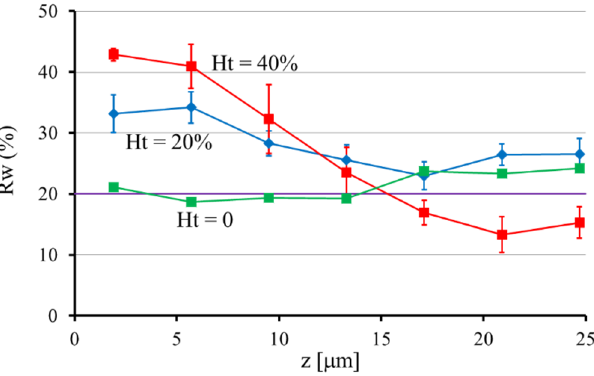
Figure 4. Number fraction of particles lying within 10 µ m from the channel wall, Rw , at various heights from the bottom face of the square channel for Ht = 0, 20%, and 40%. For the uniform distribution of particles, Rw = 20%.